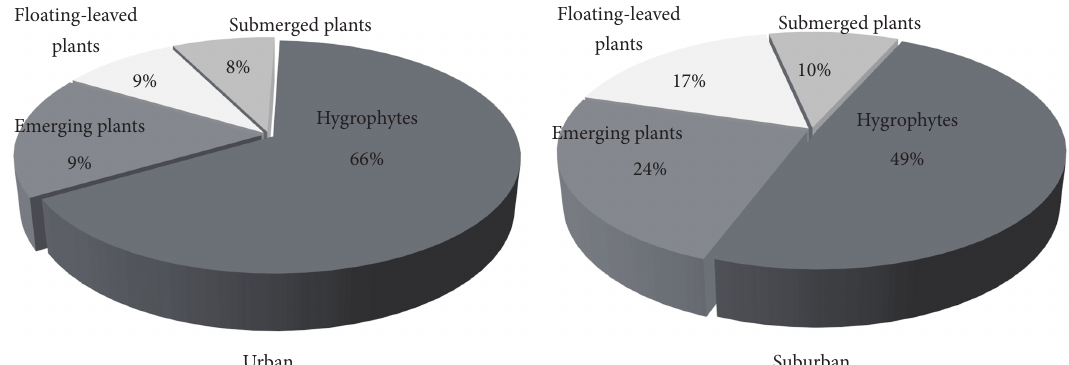
Figure 3: Percentages of aquatic plant life form urban and suburban parks.